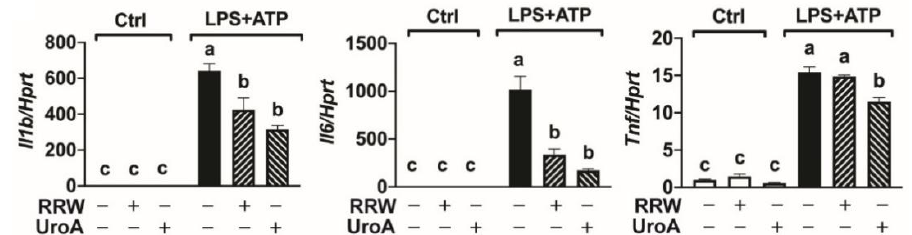
Figure 1. Both whole red raspberry polyphenols and urolithin A decreased pro-inflammatory cytokine gene expression. V-2 cells treated with LPS (500 ng/mL) for 3 h followed by ATP (2.5 mM) for 30 min with or without whole red raspberry polyphenols (10 µg/mL) or urolithin A (10 µM). Gene expression levels measured by RT-qPCR for Il1b, Il6 , and Tnf. All values are represented as the mean ± SEM. Treatments with different letters indicate significant differences by one-way ANOVA, p < 0.05. LPS = lipopolysaccharide; RRW = whole red raspberry polyphenols; UroA = urolithin A.